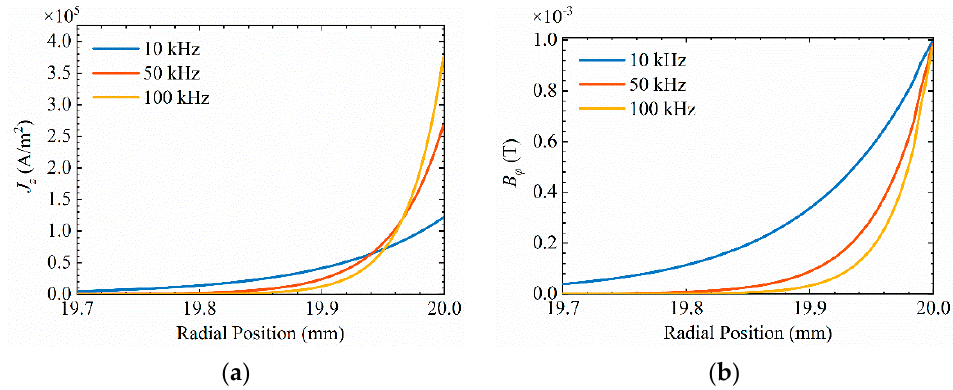
Figure 3. Distribution of eddy current and magnetic flux density along radius in the finite element model: ( a ) variation of current density with radius; ( b ) variation of magnetic flux density with ra- dius.